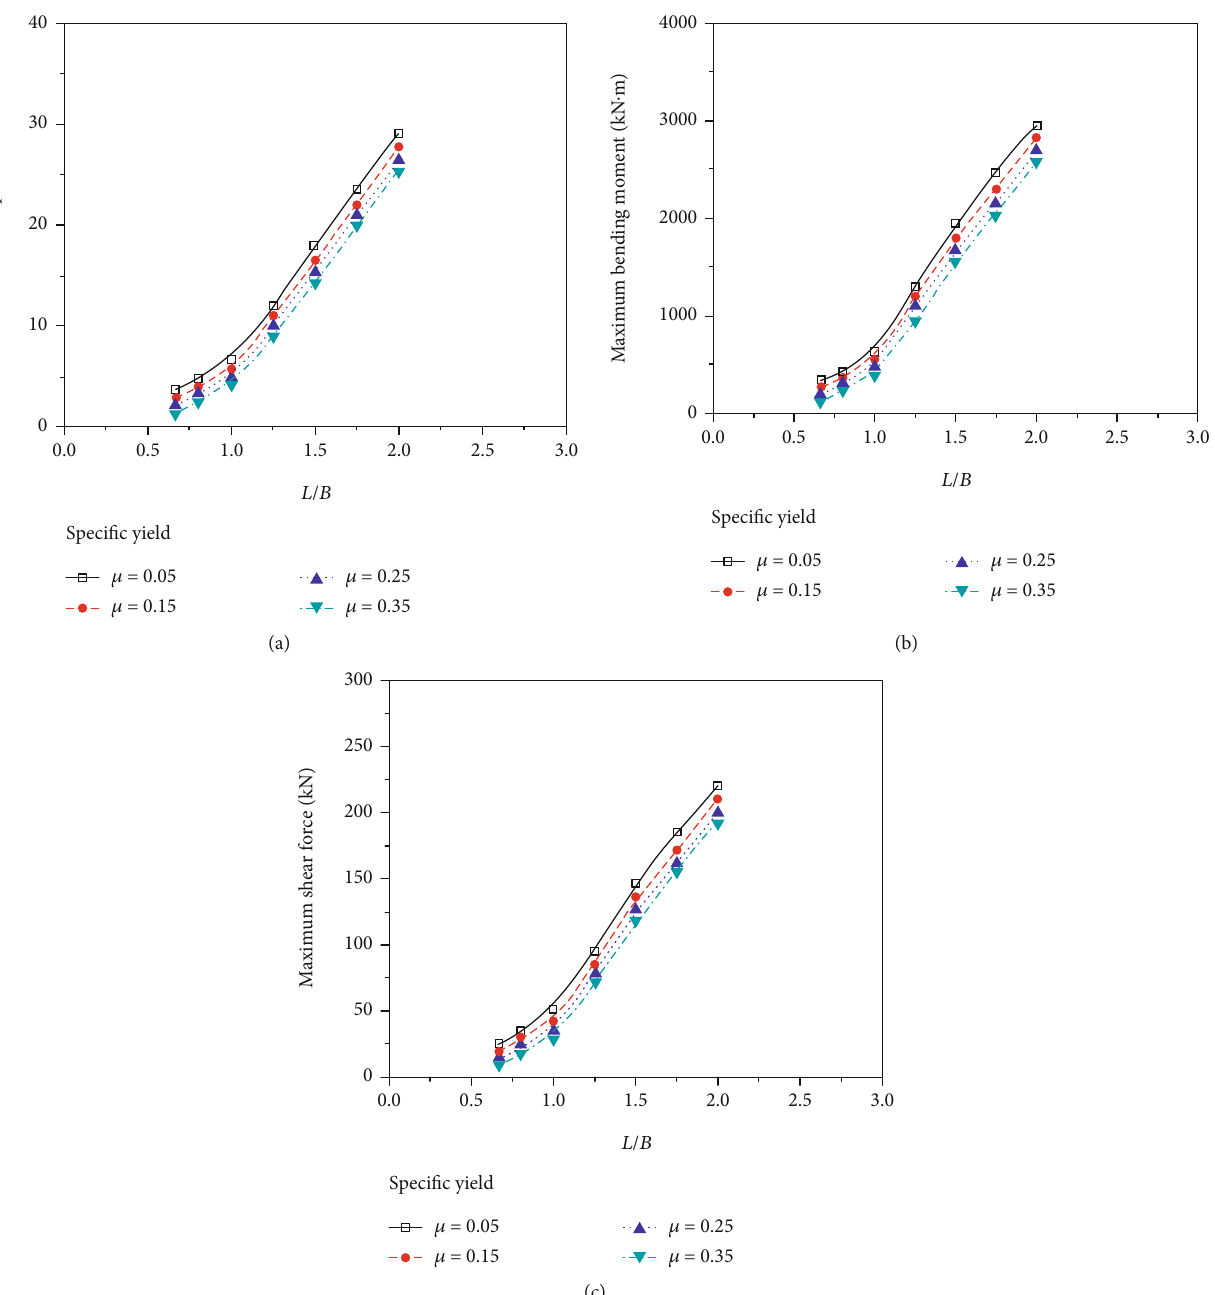
Figure 15: E ff ects of the excavation plan view size on (a) tunnel maximum vertical displacement; (b) tunnel maximum bending moment; (c) tunnel maximum shear